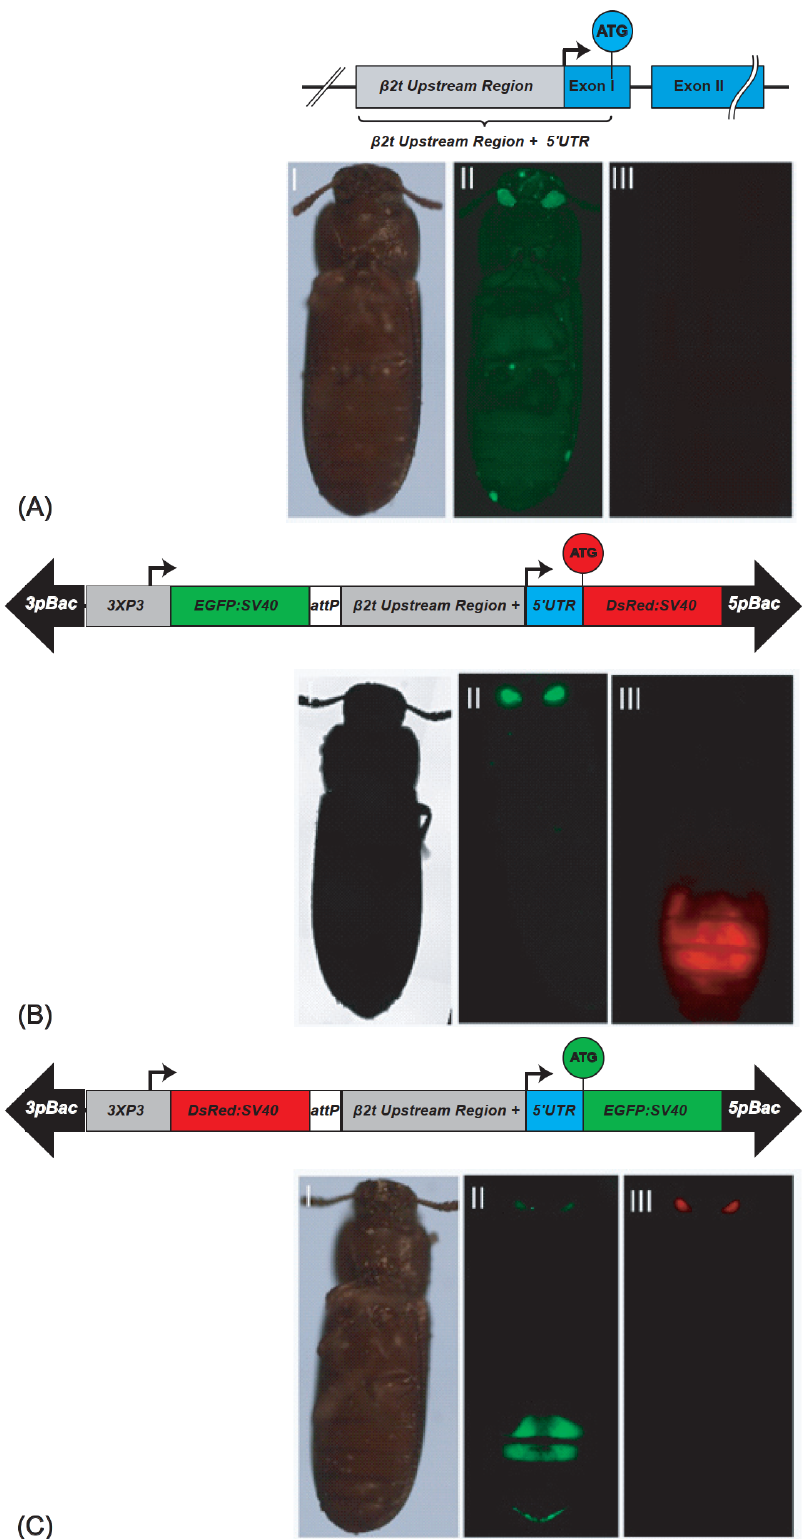
Figure 1. β 2t gene and derived sperm-marking constructs: ( A ) schematic depiction of the endoge- nous β 2t gene (TC009035) showing the upstream region in grey, the exons in blue, and the intron as black line. (A I –A III ) non-transgenic male photographed under white light, EGFP filter, and DsRed filter; ( B ) pBac{3xP3_EGFP_SV40af _ attP _ β 2t _DsRed_SV40af}: construct for red fluorescent sperm. (B I –B III ) β 2t -DsRed-SV40 carrying male photographed under white light, EGFP filter, and DsRed filter; ( C ) pBac{3xP3_DsRed_SV40af_ attP ‐ β 2t _EGFP_SV40af}: construct for green fluorescent sperm.